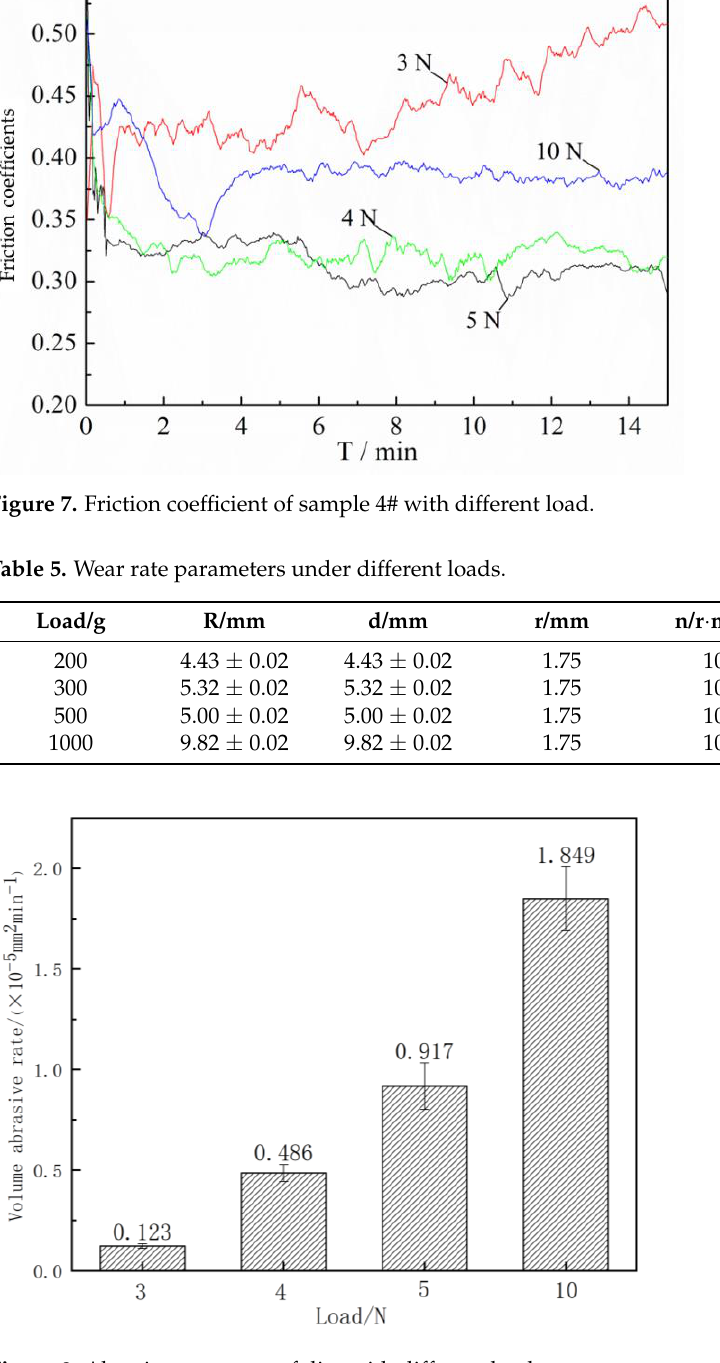
Figure 8. Abrasive wear rate of disc with different load.